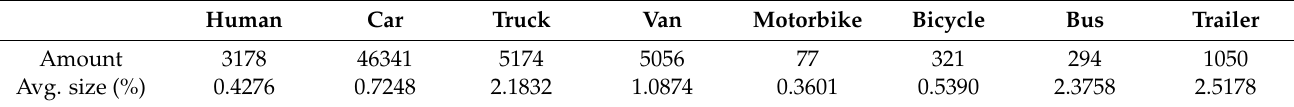
Table 1. The amount and average size of every object